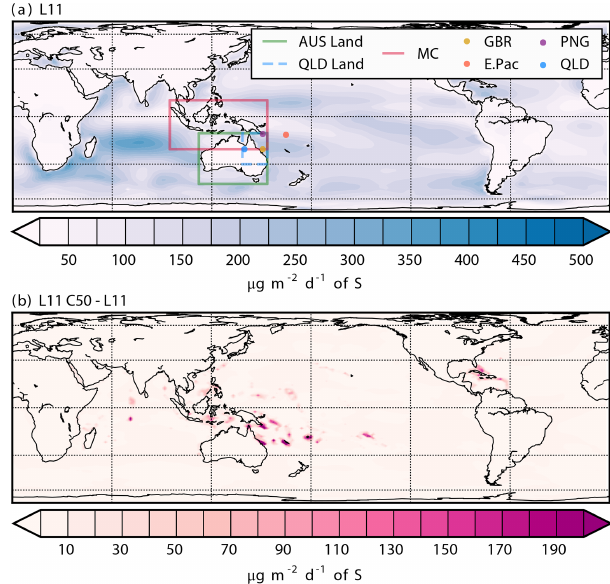
Figure 3. (a) The flux DMS (in µgm − 2 d − 1 S) based on the Lana et al. (2011) DMS w climatology and (b) the additional flux DMS in the climatology with added coral-reef-derived DMS w . In panel (a) the Maritime Continent–Australian region is shown by a red box, the Australian land-only region by a green box and the Queensland (QLD) land-only region by a blue box. Additionally, four single points used for analysis are shown over the Great Barrier Reef (GBR – yellow), Papua New Guinea (PNG – pink), the eastern Pacific (E.Pac – orange) and QLD